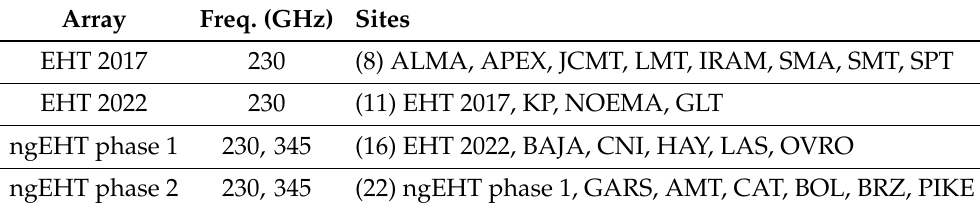
Table 1. Arrays used for synthetic data. For additional details on EHT sites, see [10]; for additional details on ngEHT sites, see [35]. Note that the SPT cannot observe M87 ∗ so does not contribute to the tests shown in this paper. New ngEHT phase 1 sites use specifications for existing facilities (HAY: 37-m, OVRO: 10.4-m) and are 6.1-m for new locations (BAJA, CNI, LAS); new ngEHT phase 2 sites assume 8-m diameters with the exception of the AMT, which is planned to be 15-m